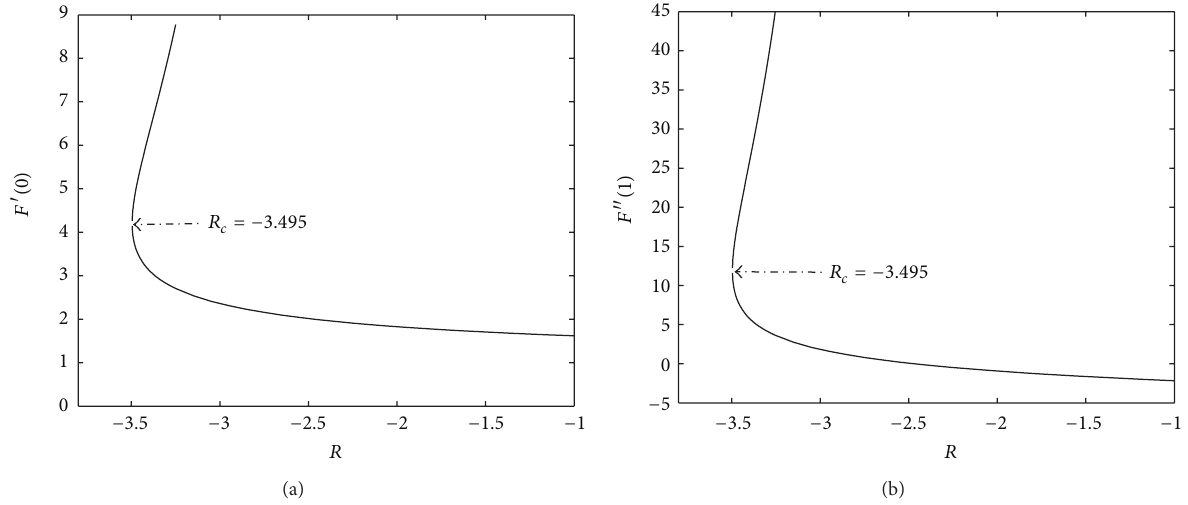
Figure 2: Slice of the bifurcation diagrams for 𝐹 󸀠 (0) and 𝐹 󸀠󸀠 (1) against 𝑅 .